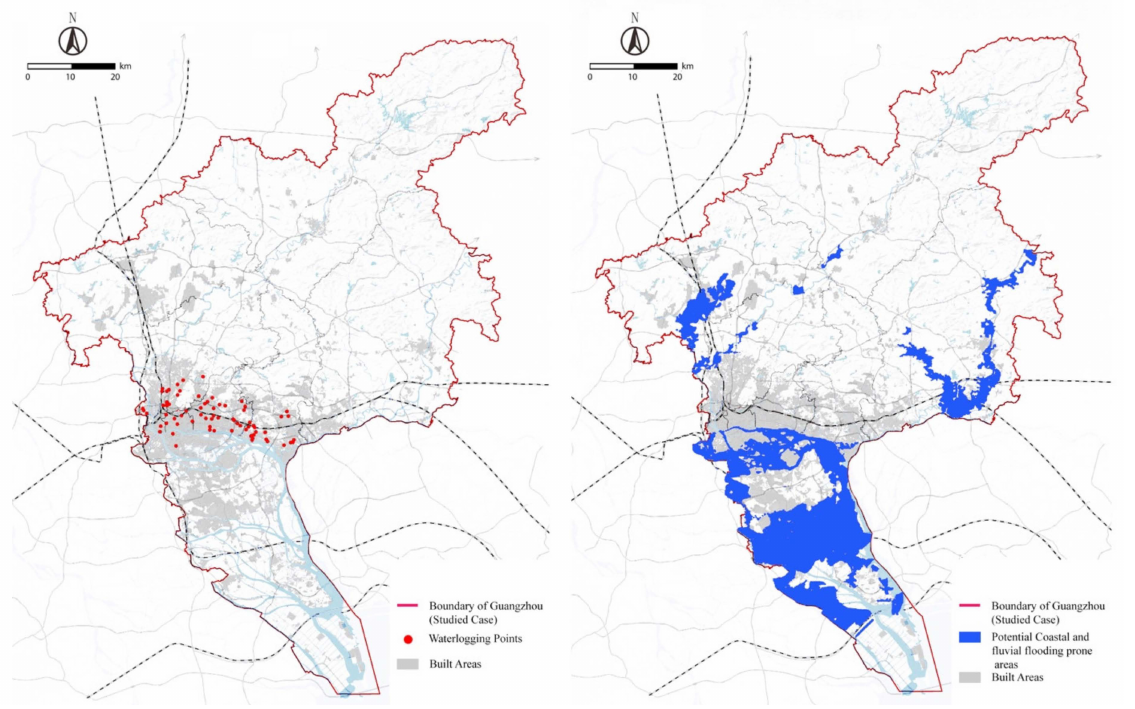
Figure 1. The waterlogging points in Guangzhou ( left ), and the areas prone to potential coastal and fluvial flooding ( right ), based on Guangzhou Sponge City Plan 2016–2030